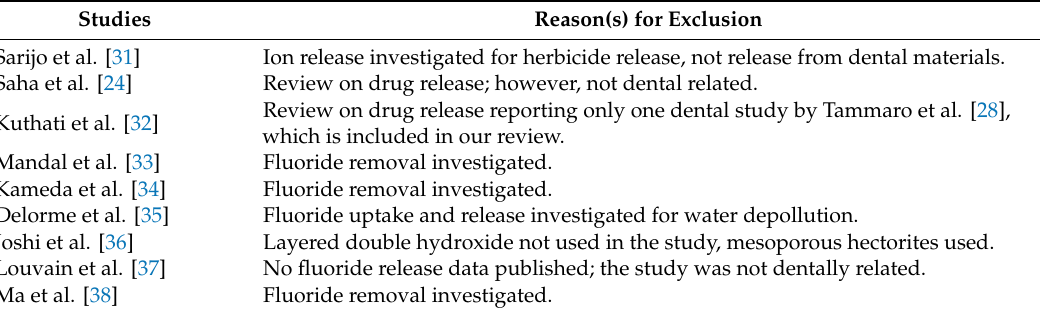
Figure 2. A flowchart of the search strategy in accordance with the PRISMA strategy. Table 3. Nine studies excluded from the review.